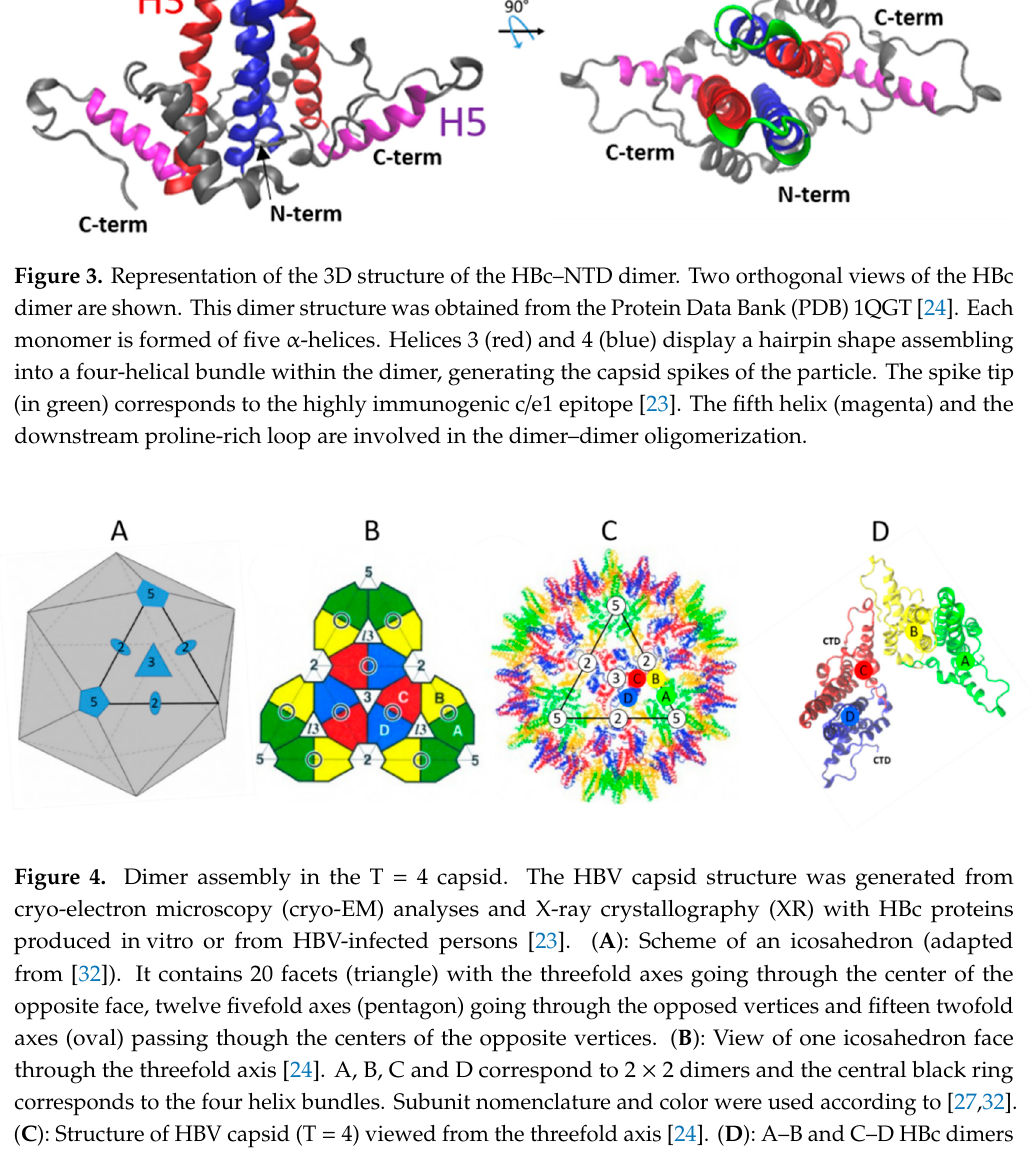
Figure 3. Representation of the 3D structure of the HBc–NTD dimer. Two orthogonal views of the HBc dimer are shown. This dimer structure was obtained from the Protein Data Bank (PDB) 1QGT [24]. Each monomer is formed of five α -helices. Helices 3 (red) and 4 (blue) display a hairpin shape assembling into a four-helical bundle within the dimer, generating the capsid spikes of the particle. The spike tip (in green) corresponds to the highly immunogenic c/e1 epitope [23]. The fifth helix (magenta) and the downstream proline-rich loop are involved in the dimer–dimer oligomerization.